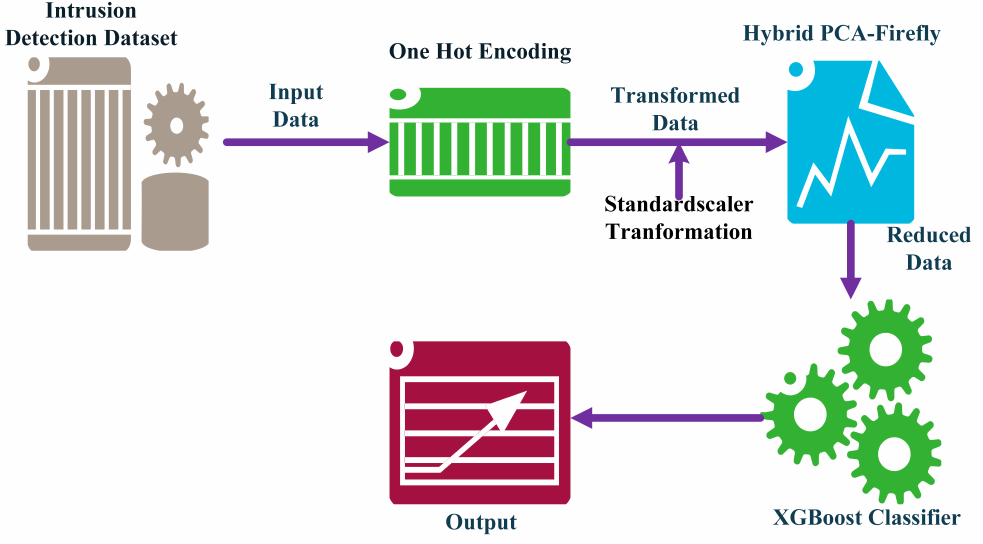
Figure 2. Proposed methodology for classification of an intrusion detection system (IDS) dataset.